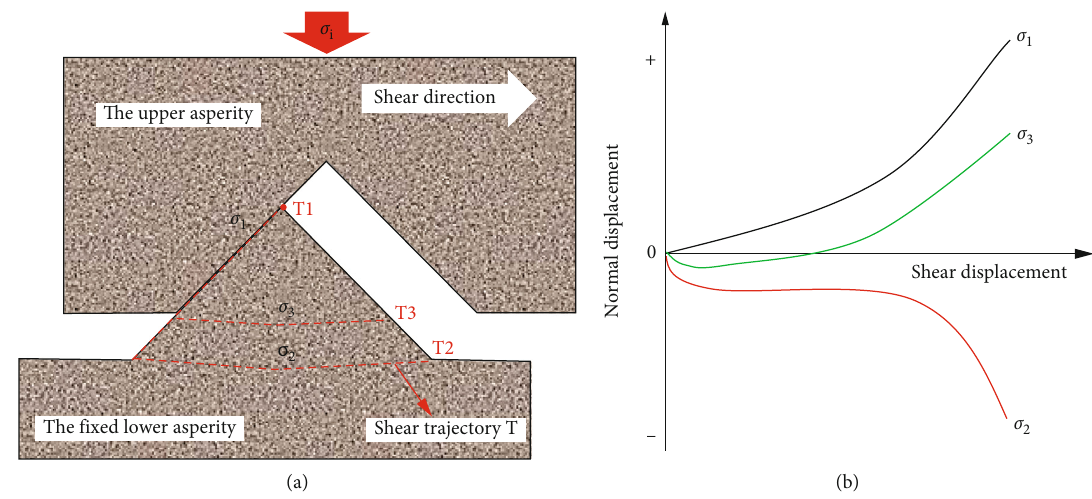
Figure 11: Failure mechanisms of shear behaviors: (a) asperity with the upper and lower blocks; (b) representative shear-normal displacement curves at di ff erent normal